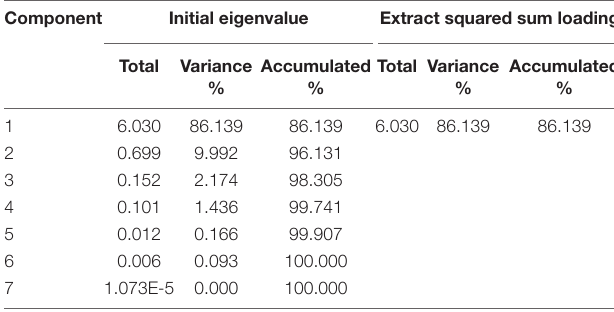
TABLE 5 | Total variance of interpretation.